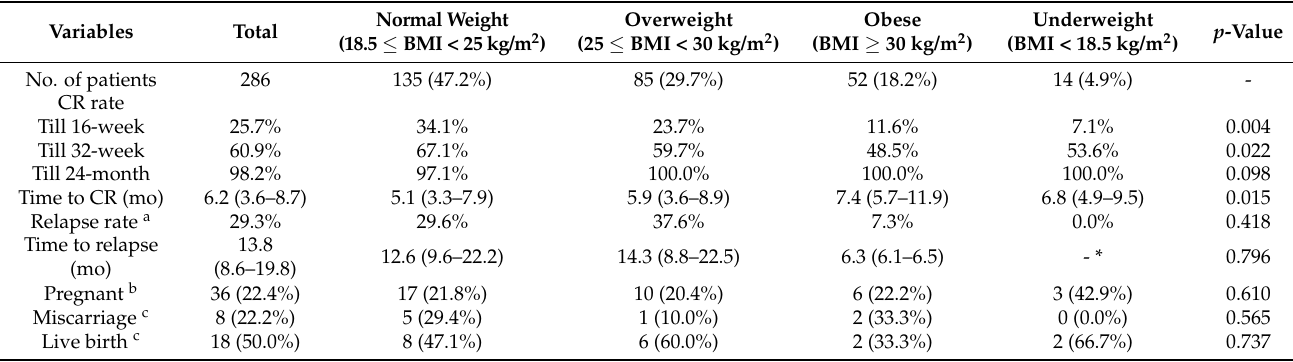
Table 3. Fertility-sparing treatment outcomes across weight